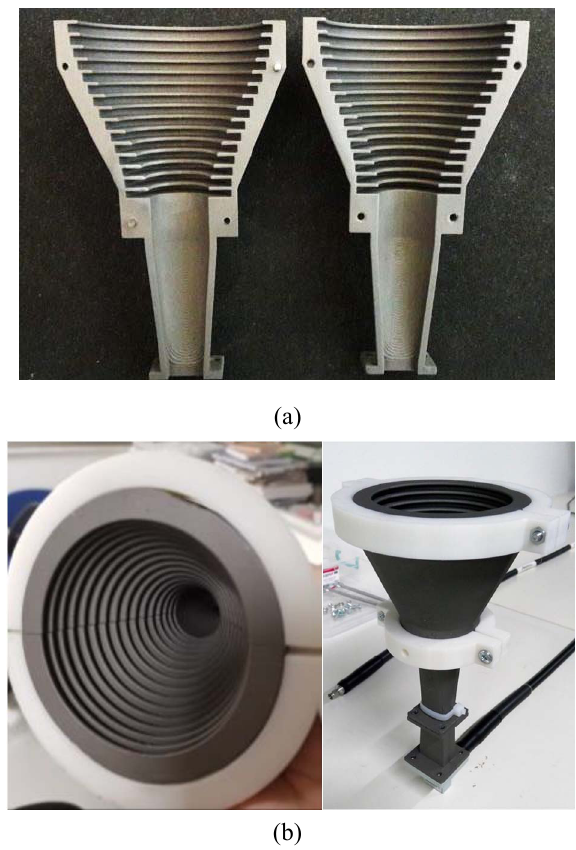
Figure 6: The manufactured views of the antenna prototype (a) produced and coated half pieces (b) Assembled antenna structure.